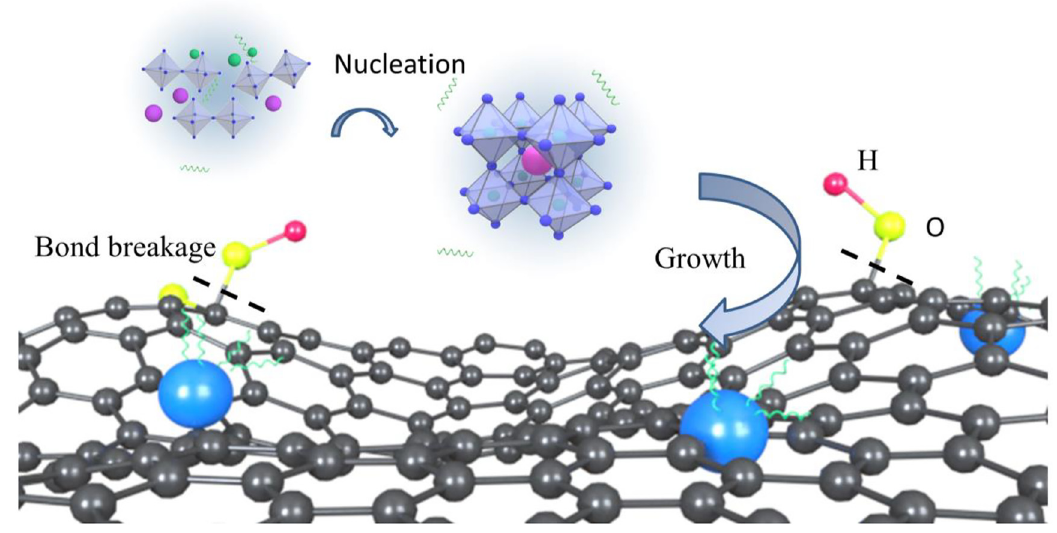
NH PbBr -G composite 3 3 3